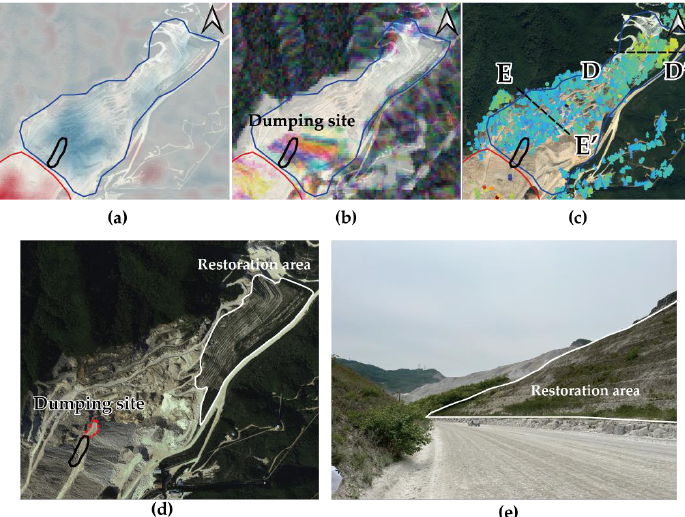
Figure 10. The resulting image of the mined-out area. ( a ) Elevation change, ( b ) RGB composite image and dumping site, ( c ) PSInSAR result image and cross-section, ( d ) 2021 aerial photograph and red dotted line are expanded dumping area, and ( e ) 2022 field photo.